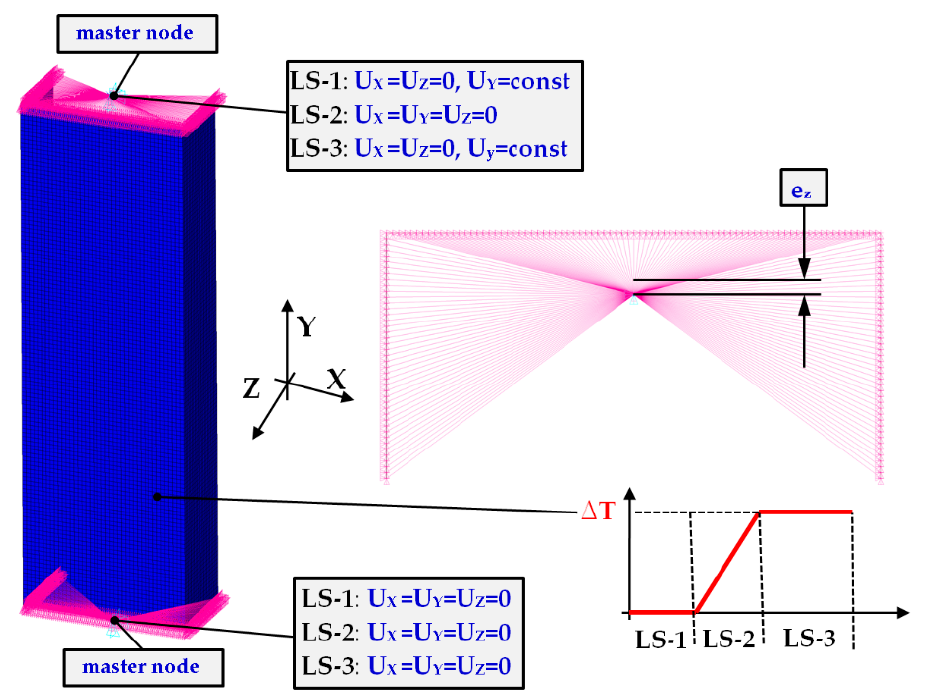
Figure 8. Boundary conditions of FEM_SHELL_1.